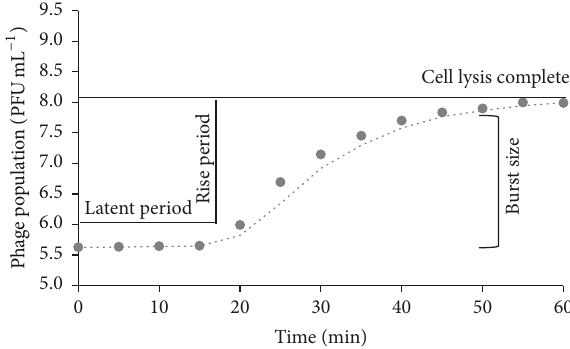
Figure 8: Predicted growth curve of phage P-1 using the 4- parameter sigmoidal function to obtain latent period (21min), rise period (27 min), and burst size (224 virions per infected